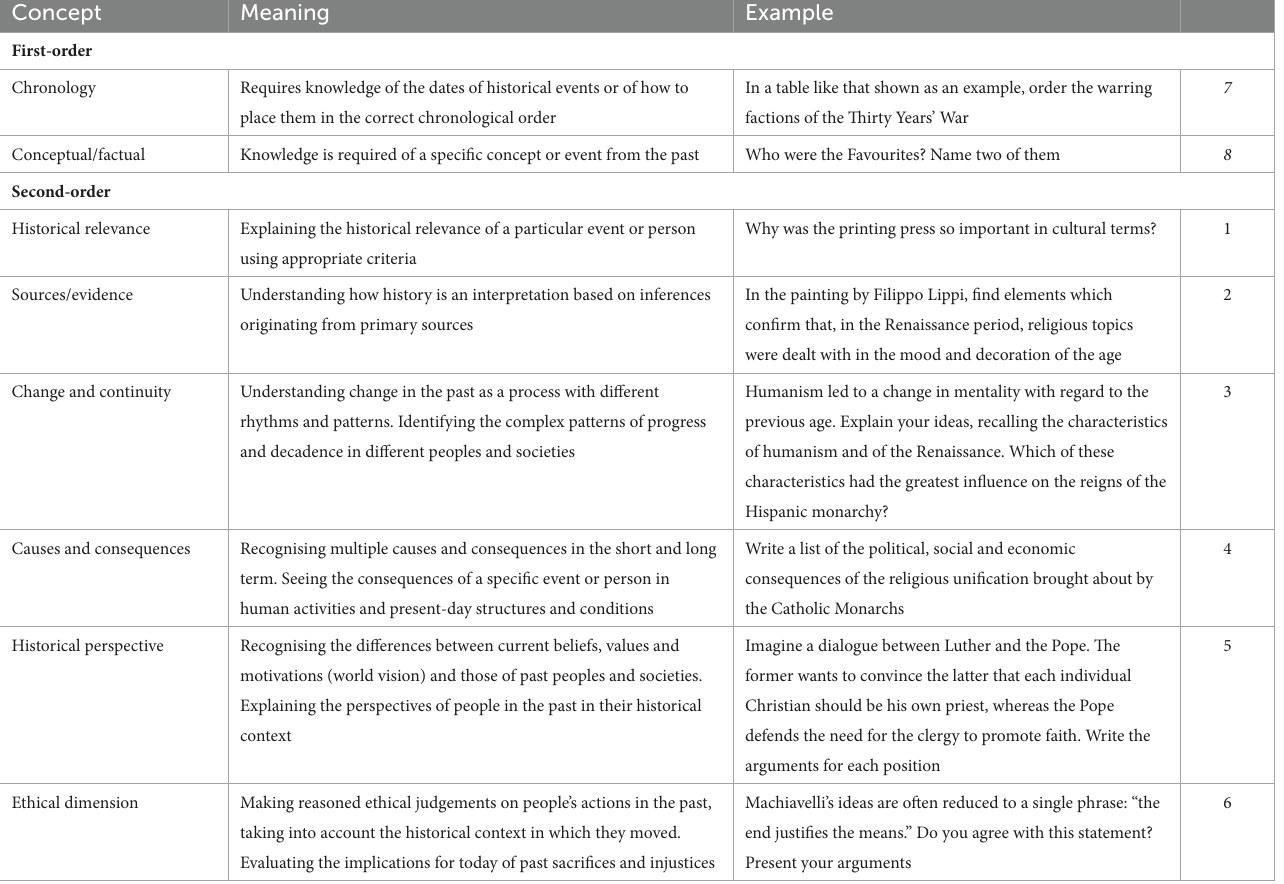
TABLE 5 Meaning and examples of the first and second-order concepts present in the activities contained in the textbooks. Concept